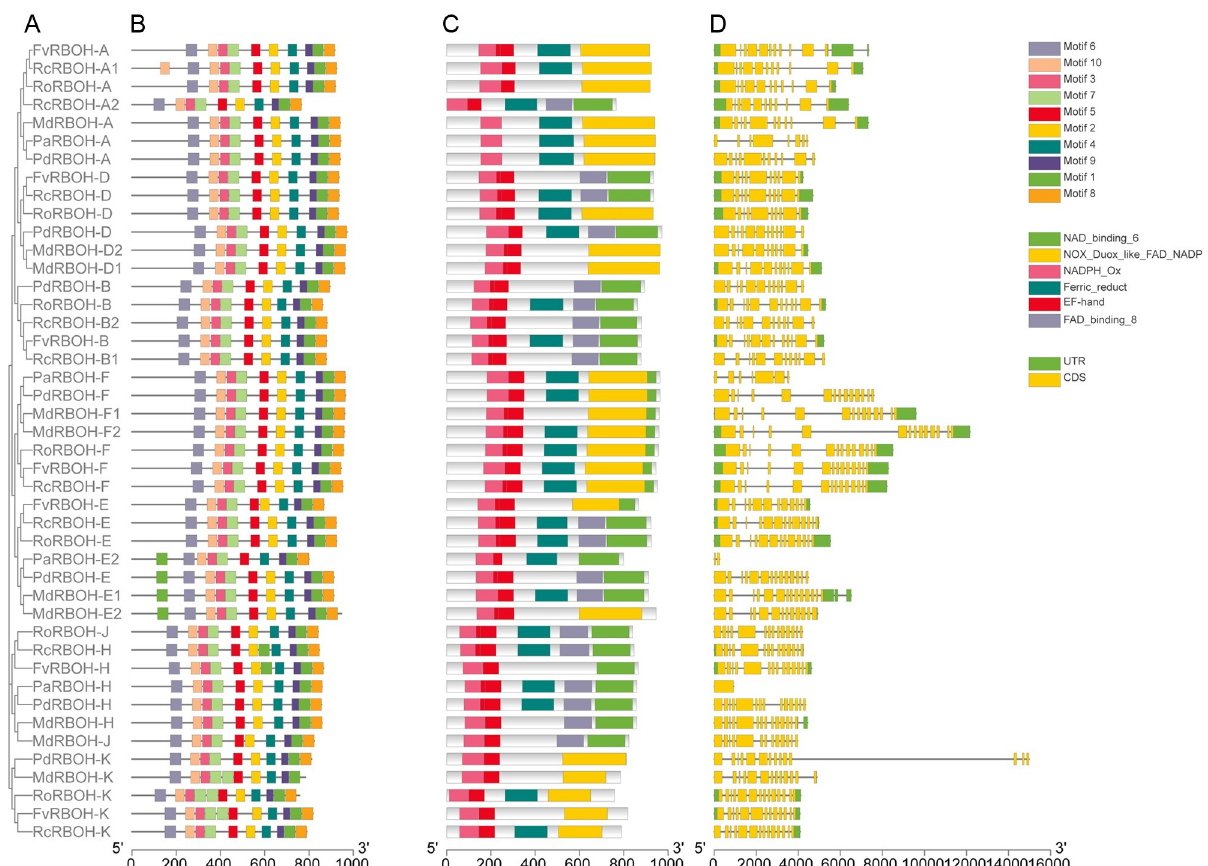
Fig 3. Phylogenetic relationships, motif composition, conserved domains, and gene structures of RBOH proteins and their corresponding genes from six Rosaceae species. (A) The phylogenetic tree was drawn based on the full-length protein sequences of RBOHs using MEGA 7.0. (B) Motifs in RBOH proteins. Ten motifs are indicated by different colored boxes. (C) Conserved domains of the RBOH proteins. Six conserved domains are indicated with different colored boxes. (D) Gene structures of the RBOHs . Introns, exons and untranslated regions (UTRs) are indicated by gray lines, yellow rectangles and green rectangles,